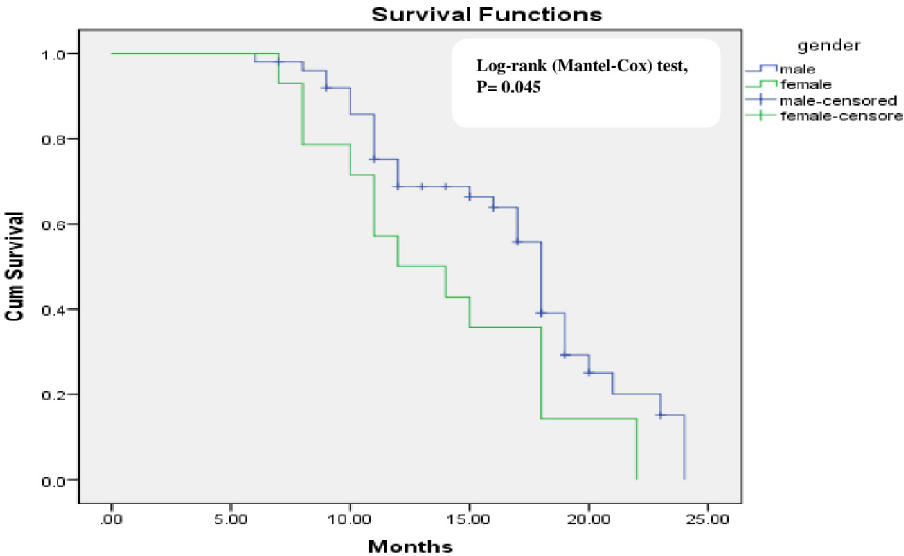
Fig 3. Kaplan-Meier survival curves showing recurrence-free survival of non-muscle invasive bladder cancer group in relation to gender.